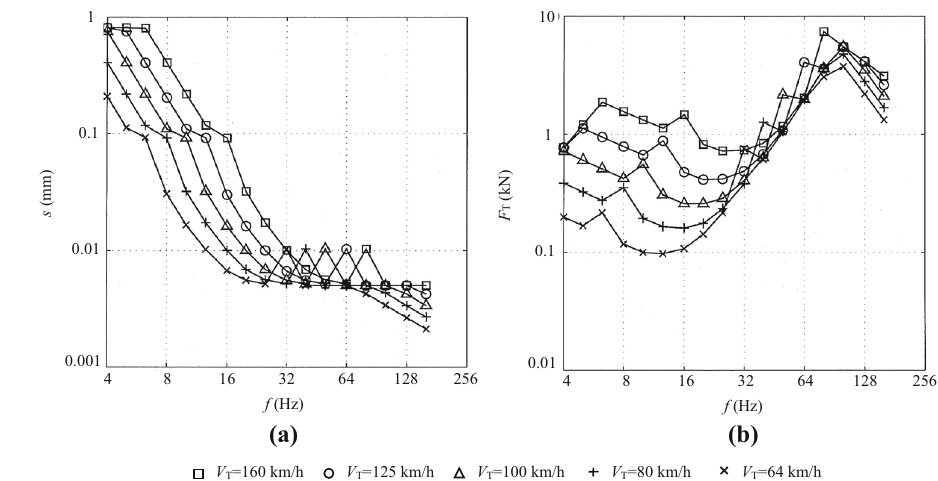
Fig. 5 Vehicle–track interaction for different train speeds: a wheel and track irregularities s and b force on the track F T